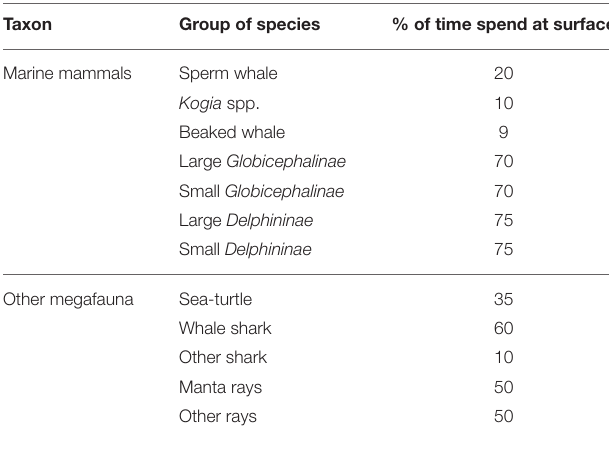
literature (see Supplementary Table